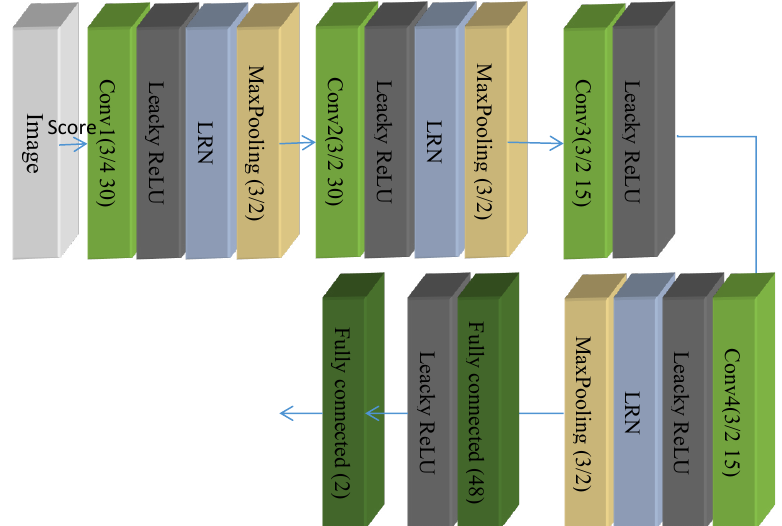
Fig. 2: EfficientParkingNet